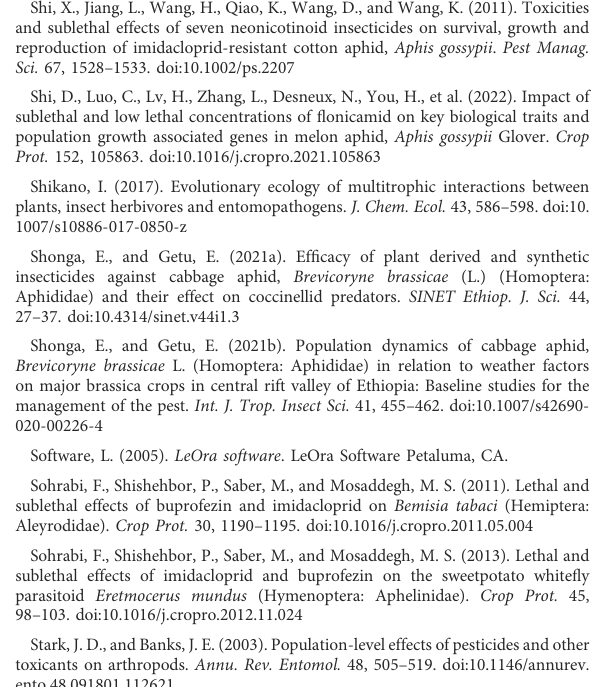
table parameters. J. Econ. Entomol. 108, 2720 – 2728. doi:10.1093/jee/tov221 Tang, Q., Ma, K., Chi, H., Hou, Y., and Gao, X. (2019). Transgenerational hormetic effects of sublethal dose of fl upyradifurone on the green peach